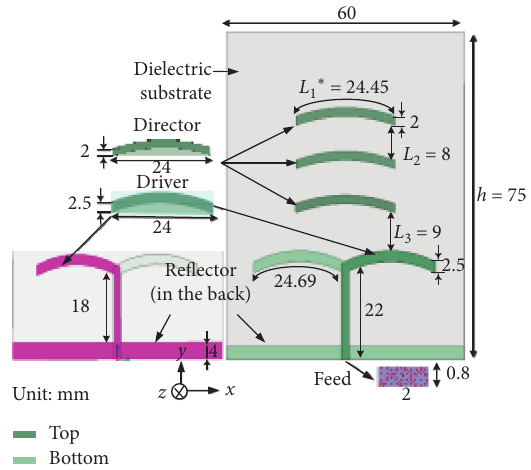
Figure 2: Layout and design parameters of the quasi-Yagi antenna with bent